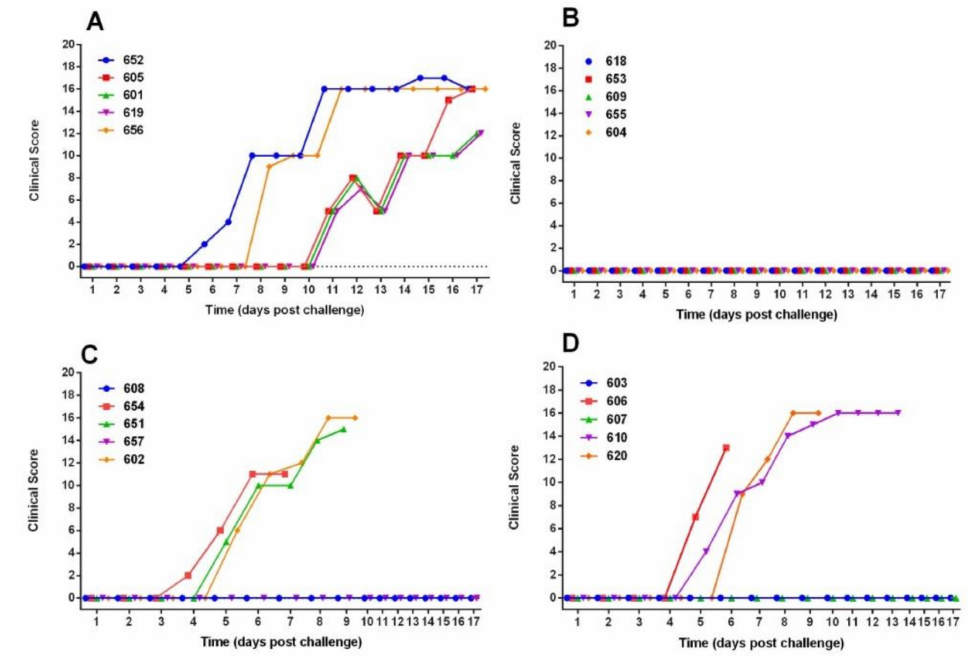
Figure 1. Clinical Score after intranasal challenge with “Margarita” strain of CSFV. ( A ) Group 1: Control animals, ( B ) Group 2: Animals immunized once five days before challenge, ( C ) Group 3: Animals immunized once three days before challenge, and ( D ): Group 4: Animals immunized once one day before challenge.